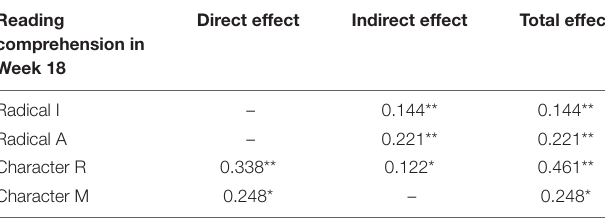
TABLE 5 | Standardized total effects, direct effects, and indirect effects on reading comprehension based on conceptual model